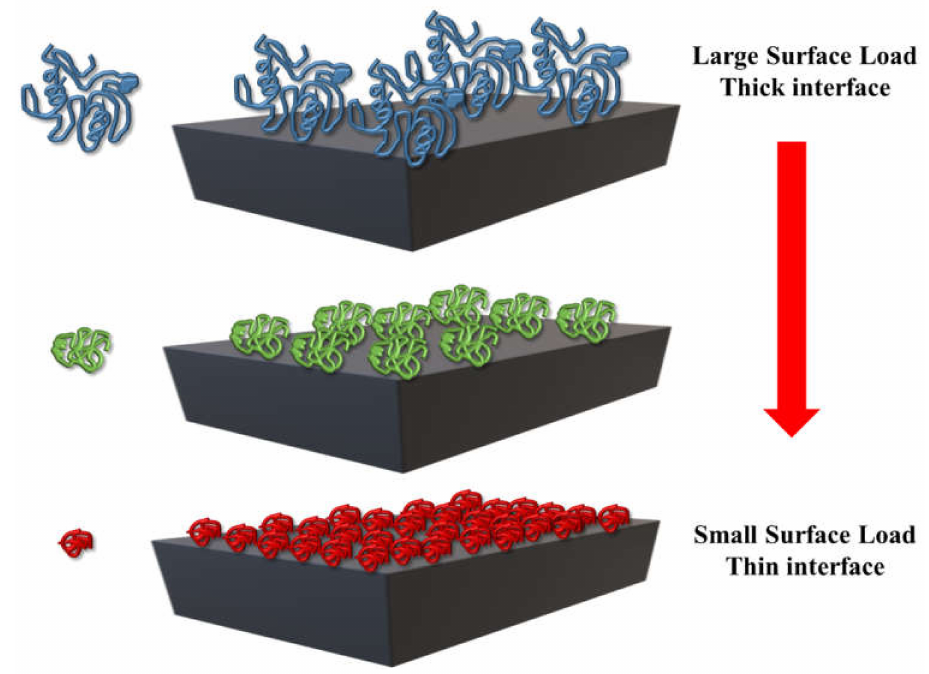
Figure 13. The surface load and thickness of a protein layer depends on the molecular dimensions and packing of the proteins at the oil-water